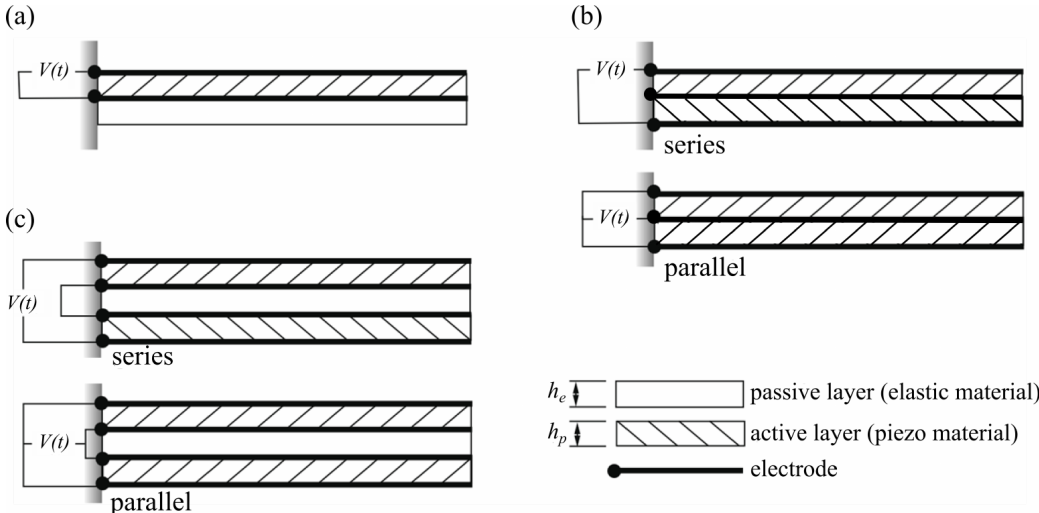
Figure 1. Piezoelectric bending actuators; illustration of the main configurations of practical interest. ( a ) Unimorph; ( b ) Double layer bimorph; ( c ) Triple layer bimorph. Sign of hatching direction illustrates sign of poling for piezo material.